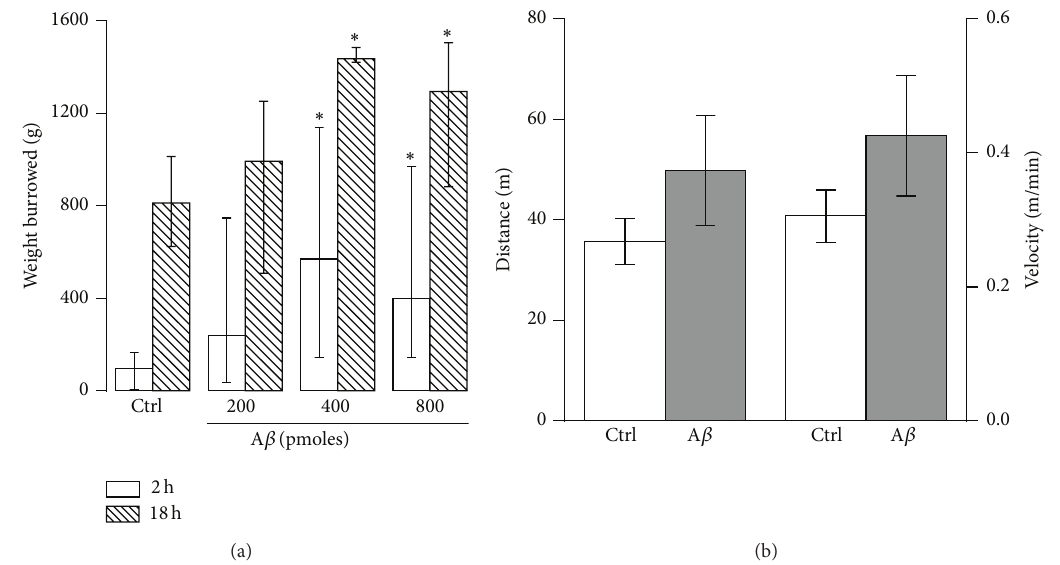
Figure 4: A 𝛽 increases burrowing without affecting motor activity. (a) Weight burrowed in the 2 h and 18 h burrowing tests by the control (Ctrl) and the groups treated with 200, 400, and 800pmoles A 𝛽 ( 𝑛 = 6–11 rats/group). Data are presented as medians ± interquartile ranges. ∗ 𝑝 < 0.05 versus Ctrl. (b) Distance (left axis) and velocity (right axis) displayed by the control (Ctrl) and the A 𝛽 (400 pmoles) groups during the 2 h of motor activity on the free running wheel ( 𝑛 = 9–11 rats/group). Data are presented as means ± S.E.M.